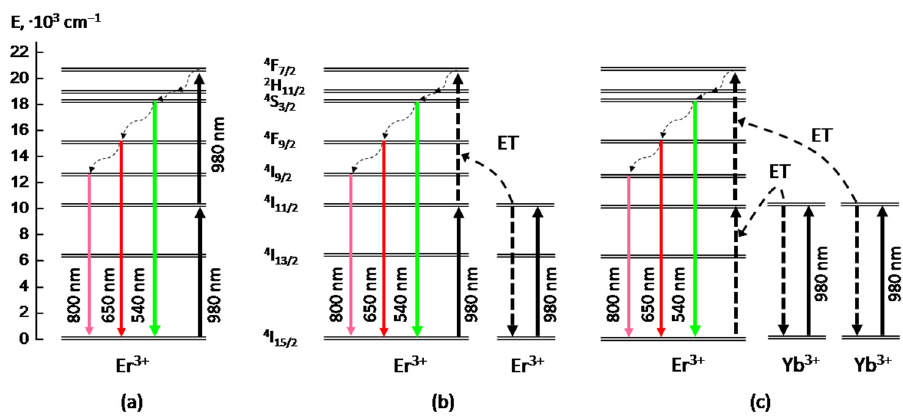
Figure 5. Energy level diagram showing mechanisms of upconversion PL excitation under 980 nm optical pumping: ( a ) “excited state absorption” (ESA) and ( b ) “energy transfer upconversion” (ETU) in Er-doped material; ( c ) “energy transfer upconversion” in Er/Yb-codoped material. “ET”— energy